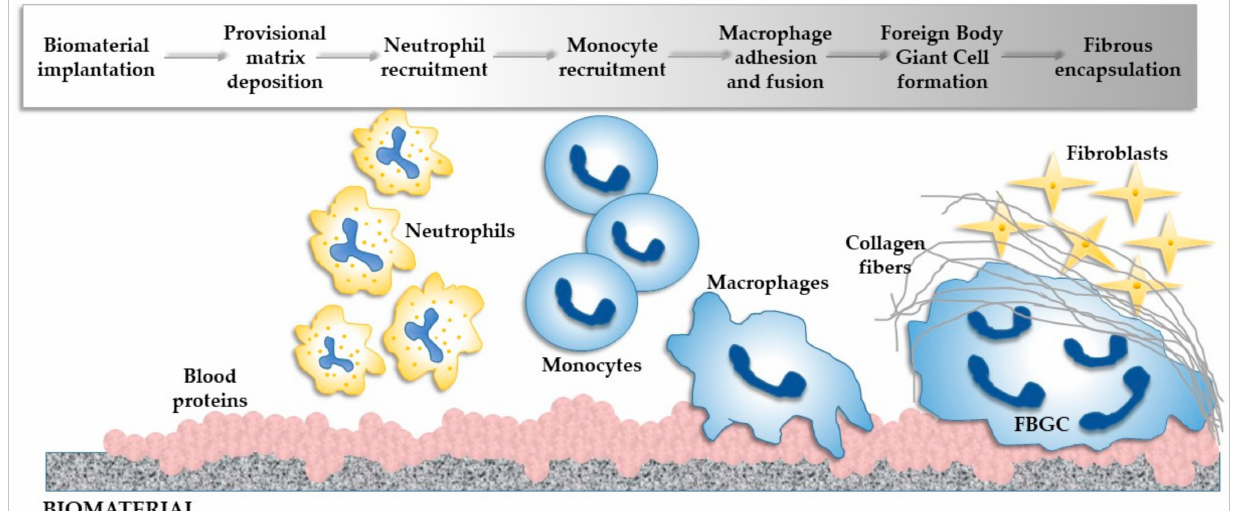
Figure 3. The sequence of events contributing to the immune response towards biomaterial